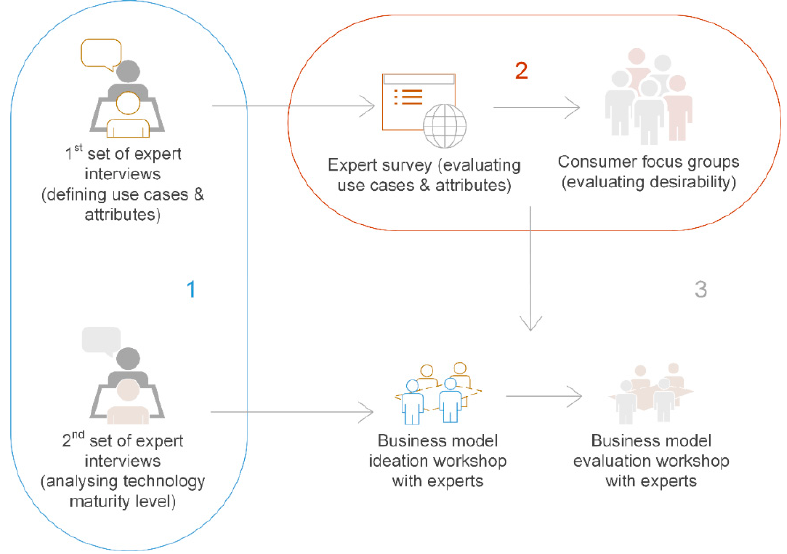
Figure 2. Three phases of the study, viz. (1) exploratory phase, (2) evaluation phase, and (3) Figure2. Threephasesofthestudy,viz. development phase.